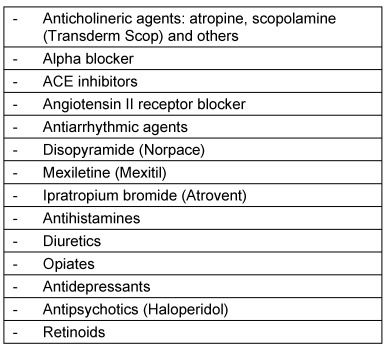
Drugs possibly inducing xerostomia (modified according to [36, 275])